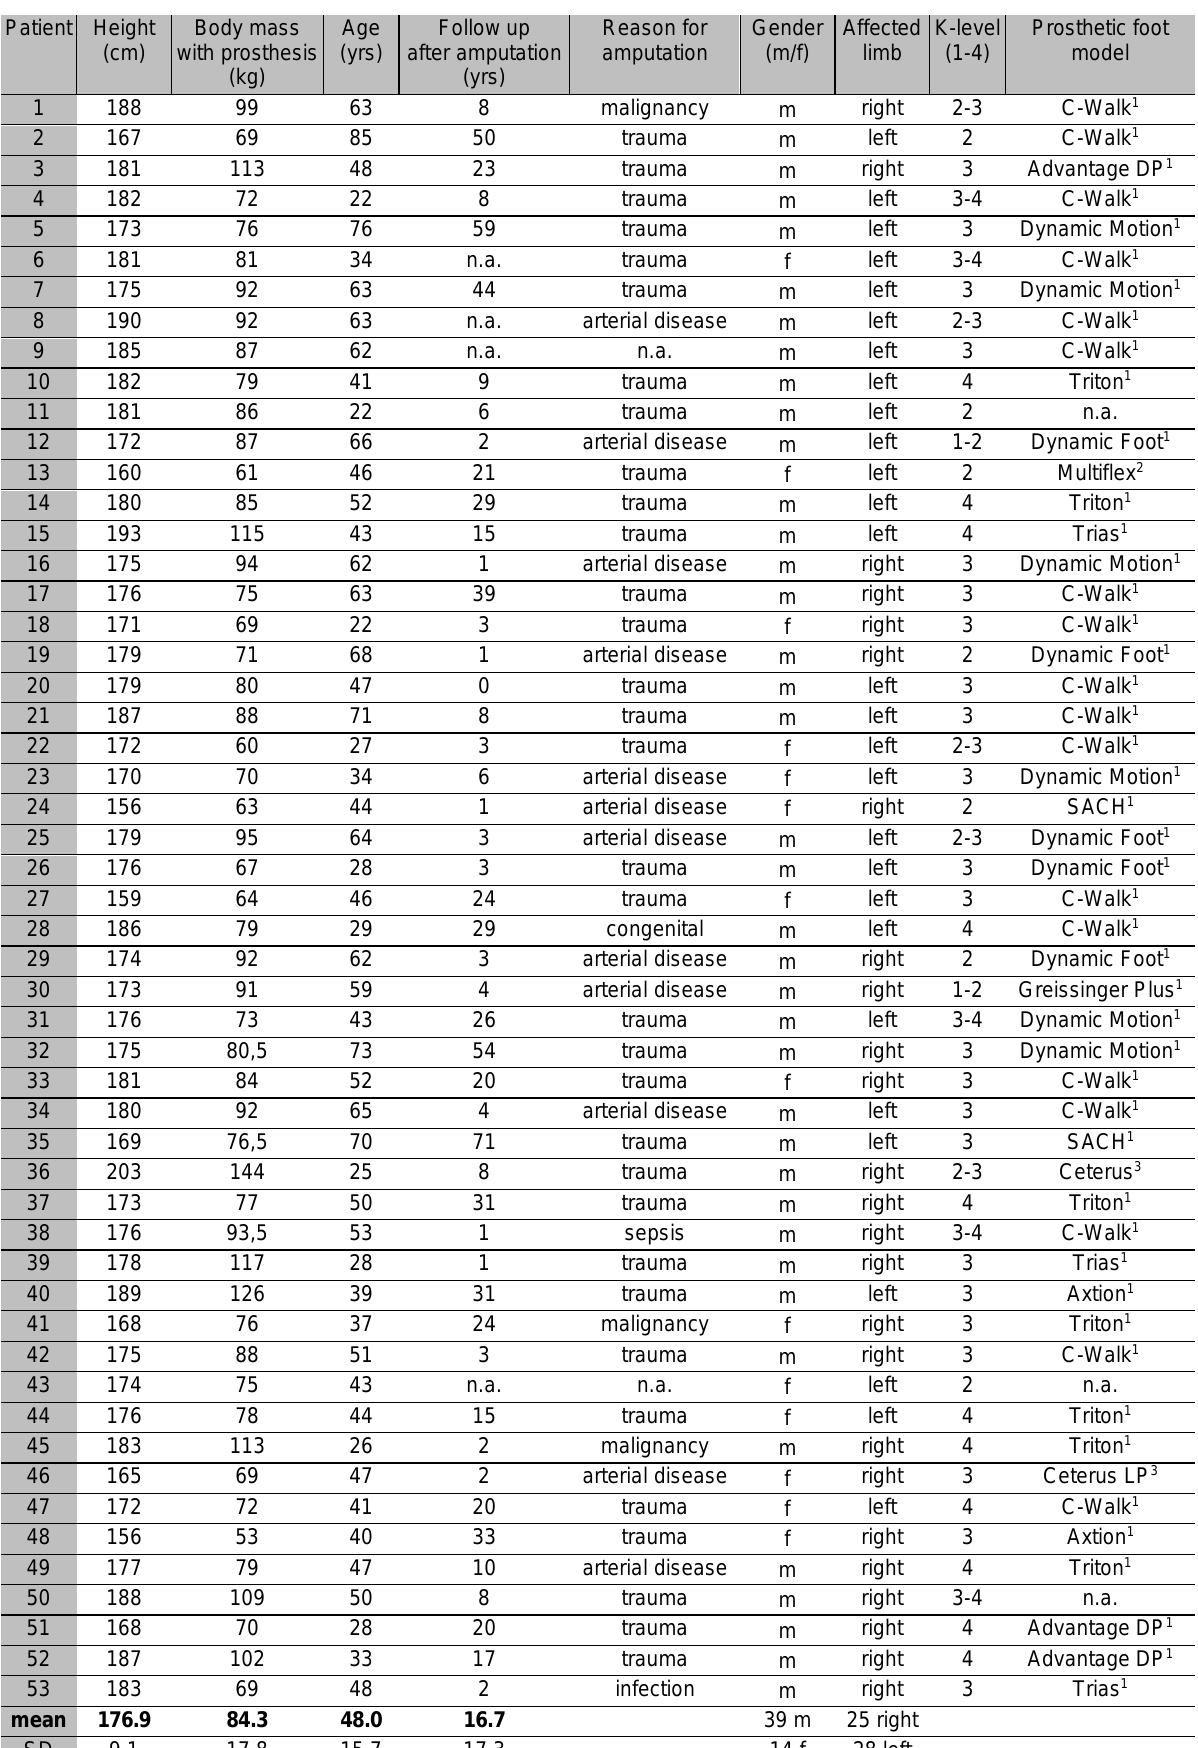
Table 2: Transtibial amputees’ anthropometric data. Patient Height